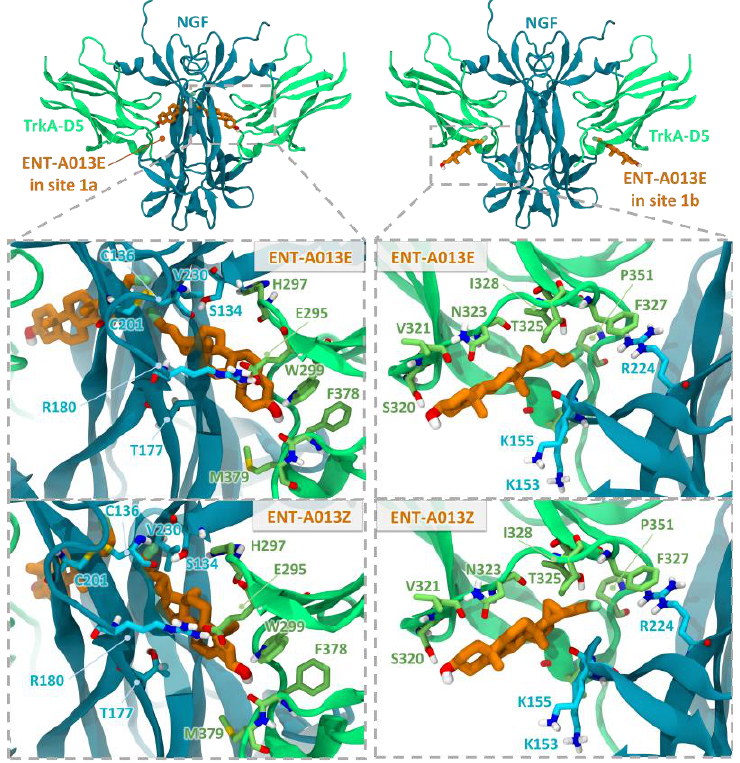
Figure 1. Docking poses of the two ENT-A013 isomers, ENT-A013E and ENT-A013Z, in sites 1a and 1b at the two symmetry-related TrkA-D5—NGF interfaces of the neurotrophin-receptor complex. The close-up views show residues lining the two sites. TrkA-D5 and NGF are shown in green and blue cartoon representation, respectively, with selected residues in stick representation colored by atom type. The compounds are shown in orange stick representation.